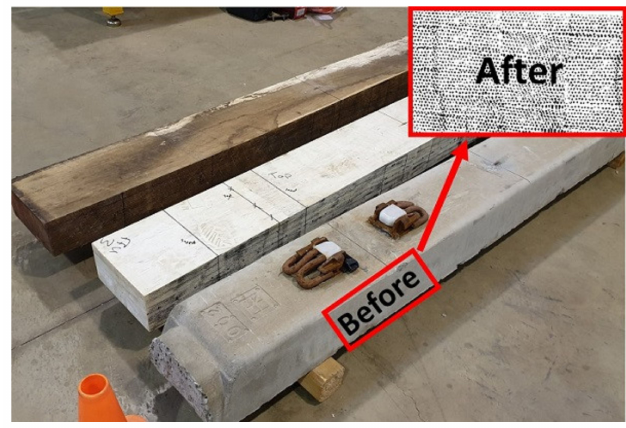
Figure 6. Sleeper samples showing applied speckle